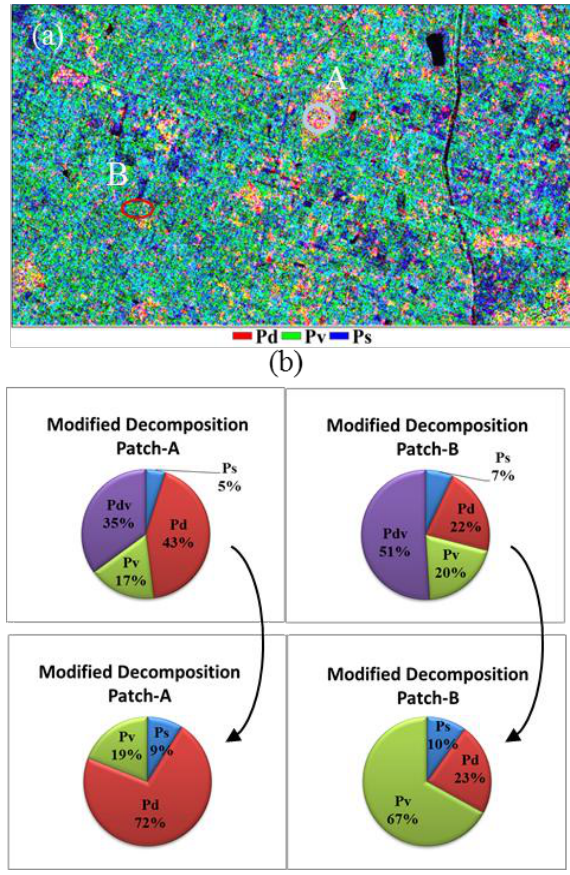
Figure 4 RGB image from new Modified polarimetric decomposition (a), corresponding percentage of different kind of scattering powers and changes after reassignment of power for Patch A and B